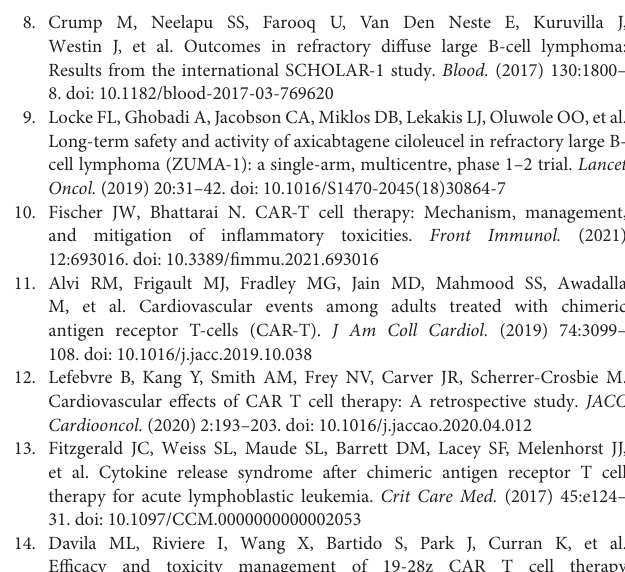
Supplemental Figure 1 | Computed tomography performed on day 5 showing bilateral pleural effusion and slight pericardial effusion. Supplemental Figure 2 | Serum C-reactive protein (CRP) levels from the day of the infusion of chimeric antigen receptor T (CAR-T) cells until day 14. CRS, cytokine release